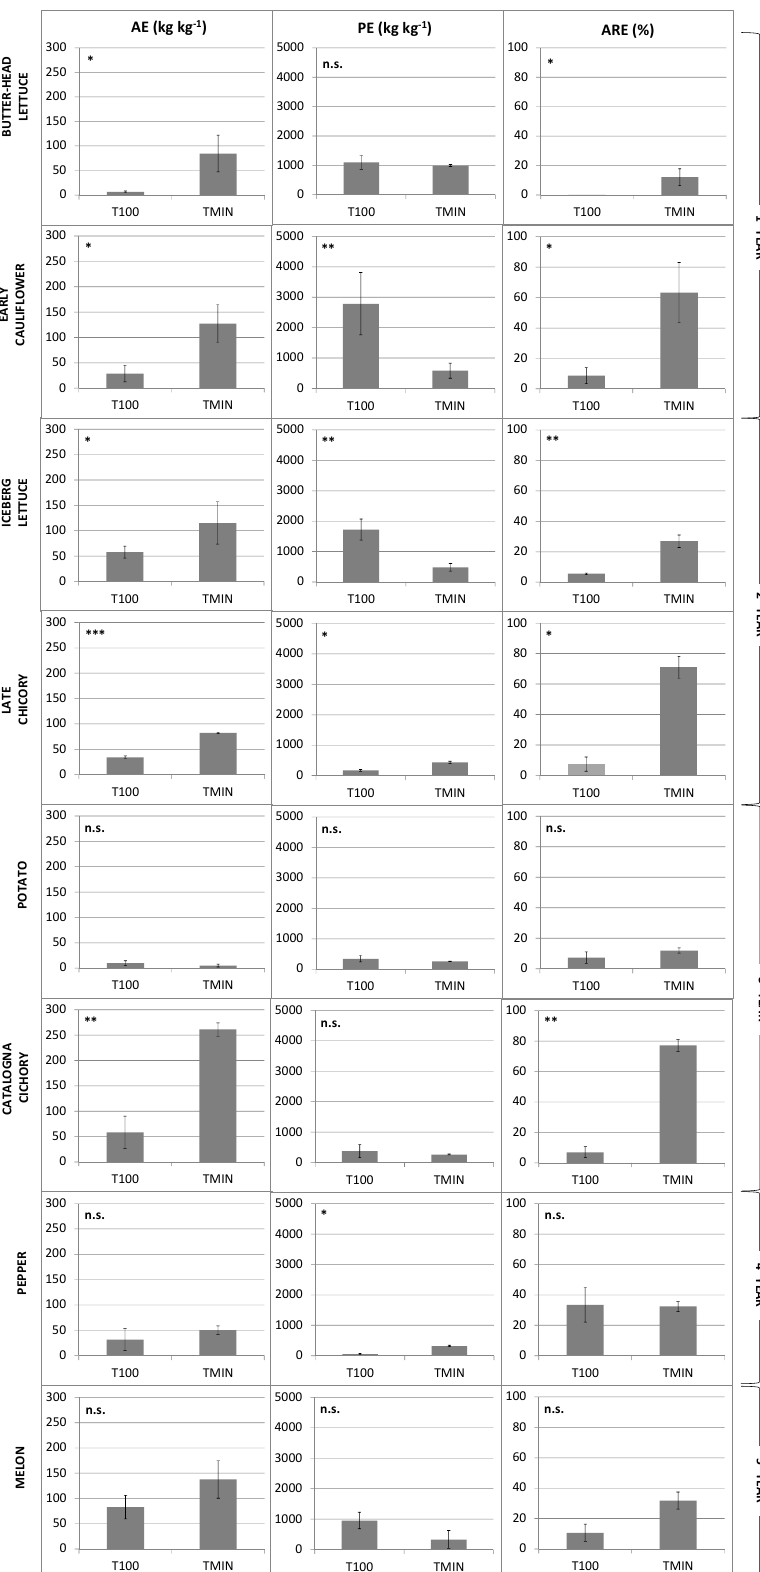
Figure 6. Nitrogen use efficiency indexes within the S2 crop succession. (AE: Agronomic efficiency; PE: Physiological efficiency; ARE: Apparent recovery efficiency). n.s.: Not significant; *: Significant p < 0.05; **: Significant p < 0.01; *** significant p < 0.001. T100: 100% N through DADRs; TMIN: Mineral control.